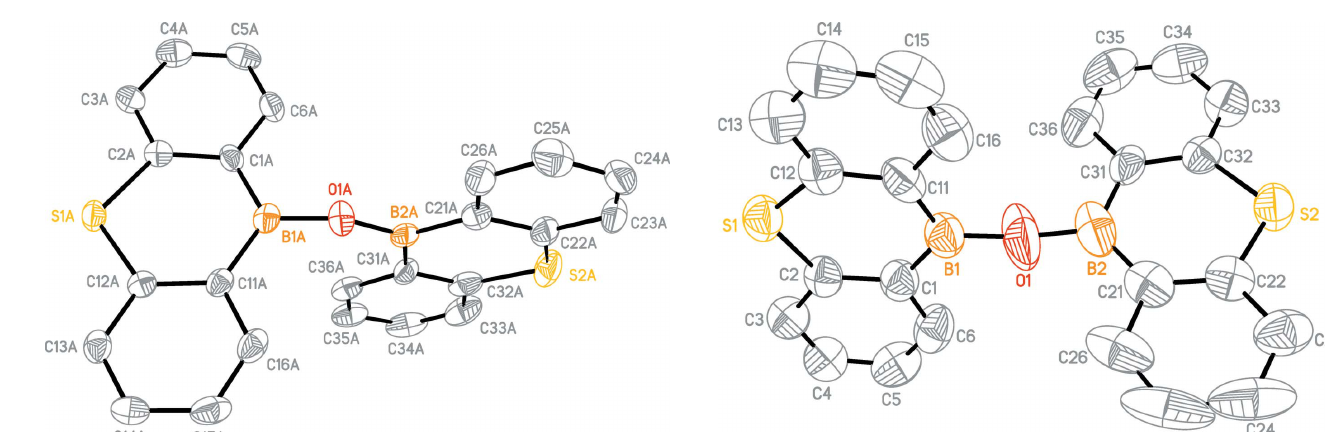
Figure 3 A perspective view of one molecule in the asymmetric unit of (II). H atoms are omitted for clarity.